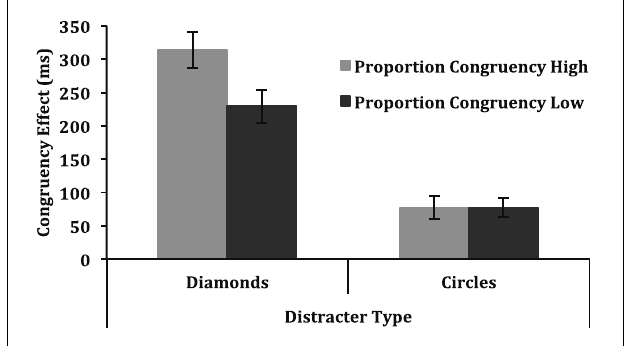
FIGURE 4 | Congruency effects (mean incongruent RT—mean congruent RT) in Experiment 2 are depicted as a function of proportion congruency (high, low) and distracter type (diamond, circle). Error bars represent one standard error of the